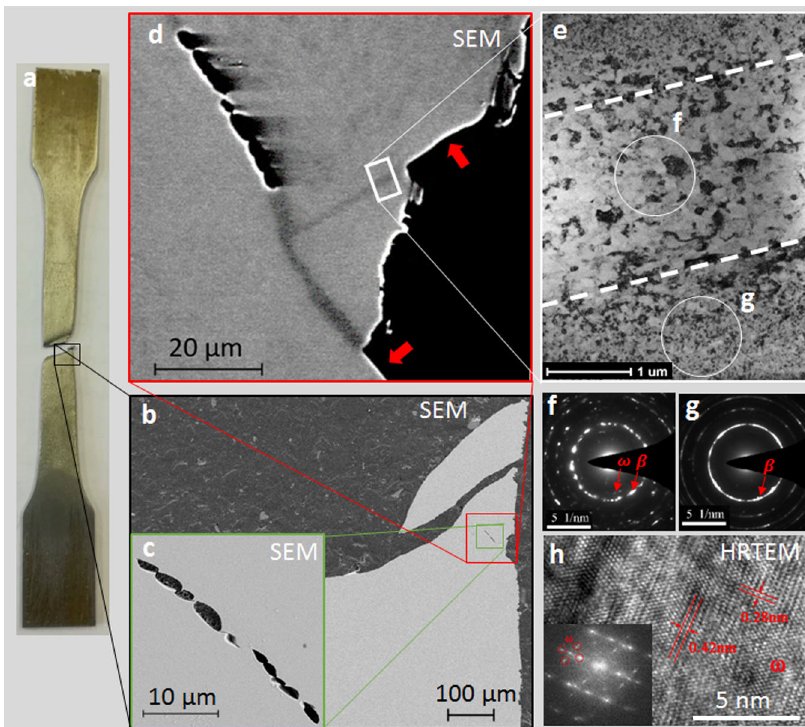
Fig. 2 Damage in localized shear bands. a After testing, a fractured tensile specimen was polished to a third of its thickness. b Secondary electrons SEM micrograph shows that there is almost no cavity in the fractured tensile specimen. c The only cavities observed are aligned in a micro-crack. d Backscattered electrons contrast shows that the cavities are formed within localized shear bands located underneath the fracture surface. The two red arrows indicate the shear offsets resulting from the shearing process. The white rectangle indicates the location where the TEM foil was extracted by FIB. e TEM bright- fi eld micrograph revealing the microstructure inside the band (equiaxed grains) and outside the band (nanoblocks). The limits of the band are highlighted by dotted lines. f – g Selected area electron diffraction (SAED) patterns taken inside the band and outside the band, respectively. While ω spots are detected in f together with the β spots, the ω spots are not visible in g . h High-resolution TEM micrograph revealing the presence of ω phase inside the band ( f ). The HRTEM micrograph was taken along the <111> zone axis of the β phase. The measured distances of 0.42 and 0.28 nm within the precipitate correspond to the interplanar spacings of the (110) and (100) planes of the ω